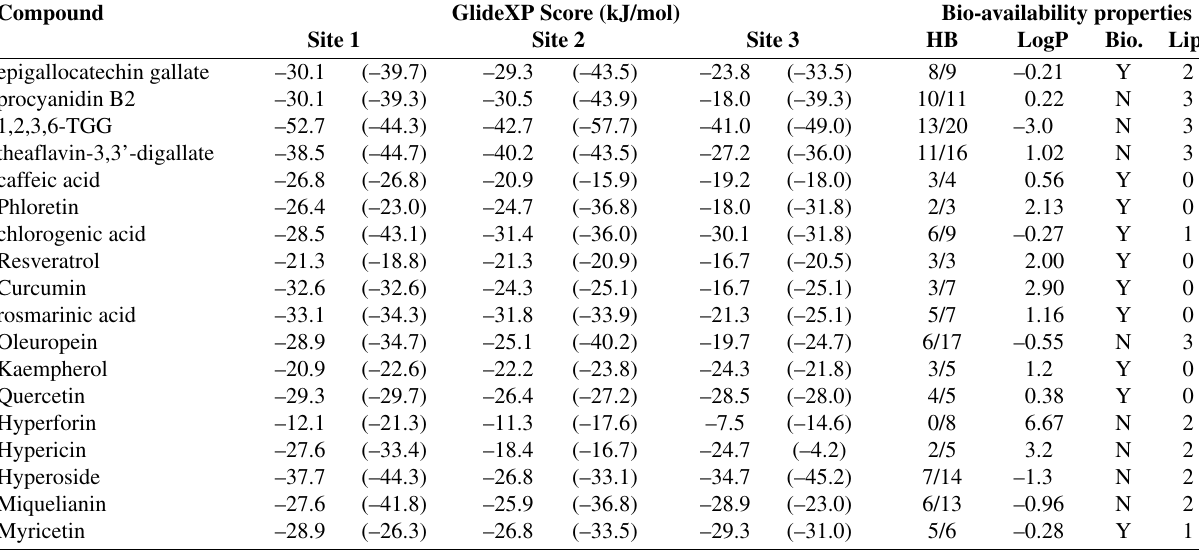
Table 2: Docking Scores for natural ligands bound to three different sites of VP24